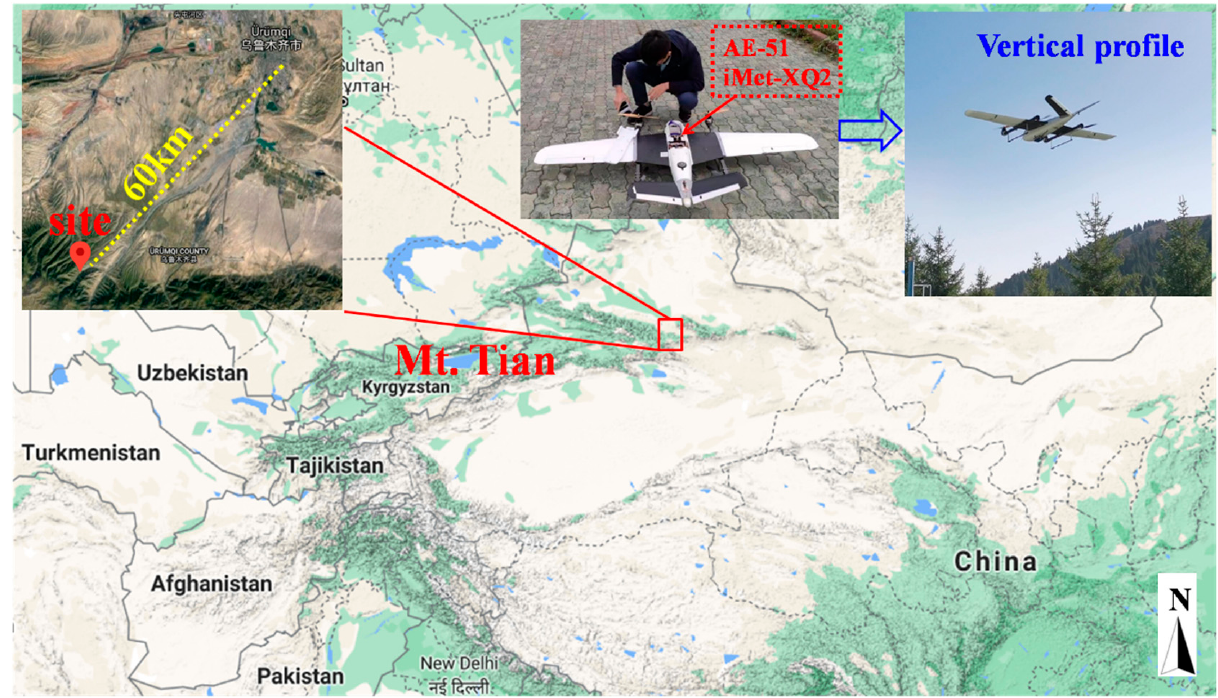
Figure 1. Locations of the observation site and surrounding areas. The UAVS (Jiangsu Environmental Innovation & Service Ltd. Co, Nanjing, China) can measure the vertical profiles of meteorological elements and BC mass concentration. The UAVS with a fixed wing had a length of 1.2 m and a wingspan of 2.16 m, which was made of expanded polyolefin (EPO) foam, as shown in Figure 1. A meteorological sensor, iMet-XQ2 (Inter MET Inc., Grand Rapids, MI, USA), a self-contained sensor package designed for the UVAS to measure atmospheric pressure, temperature, and relative humidity, was carried by the UVAS. It was also equipped with a built-in GPS and an internal data logger, along with a rechargeable battery. Detailed information about the iMet-XQ2 can be referred to in reference [52]. The mass concentration of BC was observed by a micro-aethalometer AE-51 (Magee Scientific, Berkeley CA, USA), which measures the light transmission through a Teflon-coated glass fiber filter at 880 nm. A change in filter attenuation is then translated to the mass concentration of BC particles. The introduction of AE-51 can be found in the related documents [53,54]. The UAVS takes off and lands at a speed of 1 m/s − 1